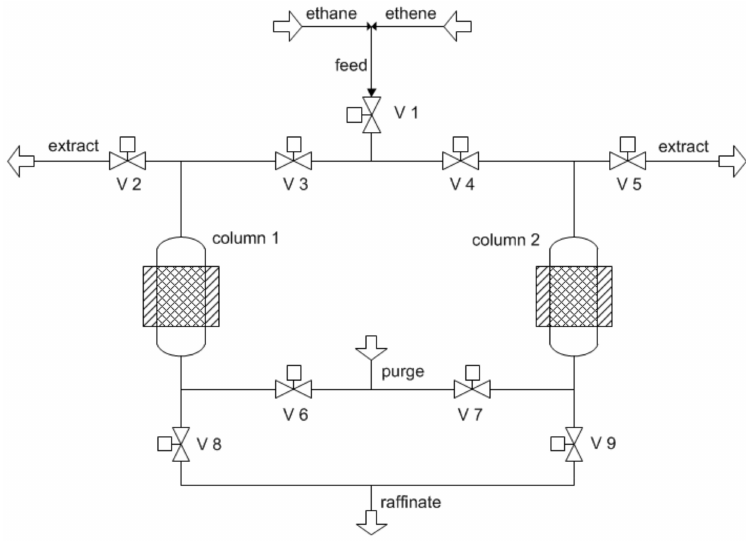
Figure 9. Simplified schematic view of the applied two-bed pressure swing adsorption (PSA)